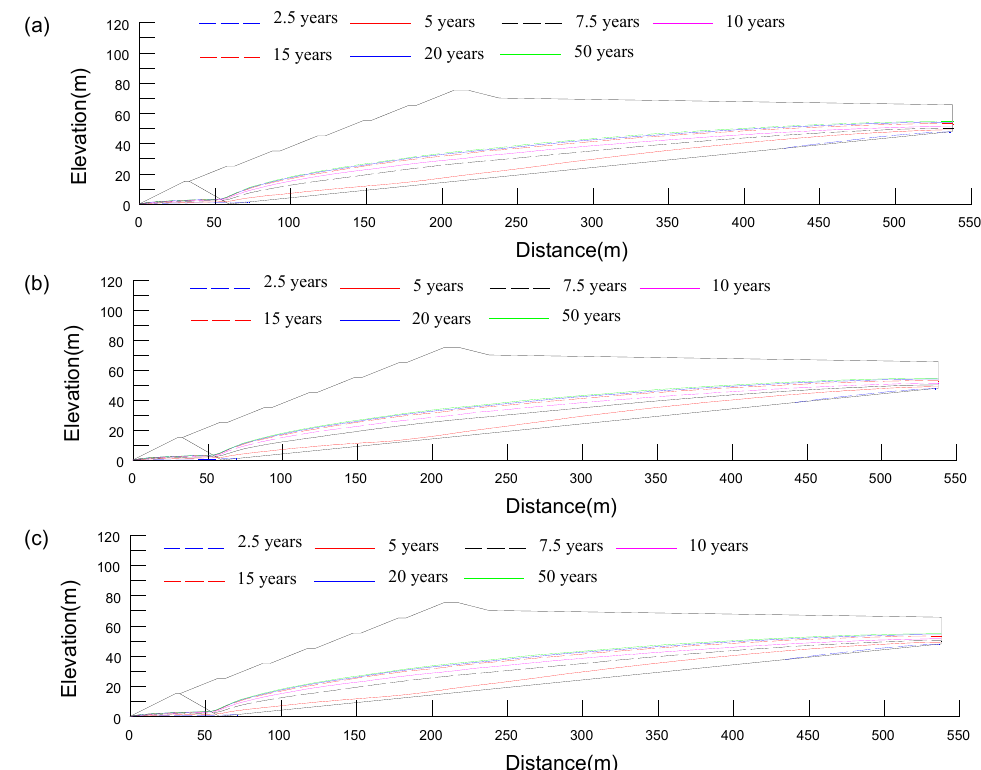
Figure 7. The spatial–temporal evolution law of the saturation line in the tailings pond (Zhengzhou, 800 mm): ( a ) Zhengzhou 2018 (caseII ‐ d); ( b ) Zhengzhou 2019 (caseII ‐ e); ( c ) Zhengzhou 2020 (caseII ‐ f).